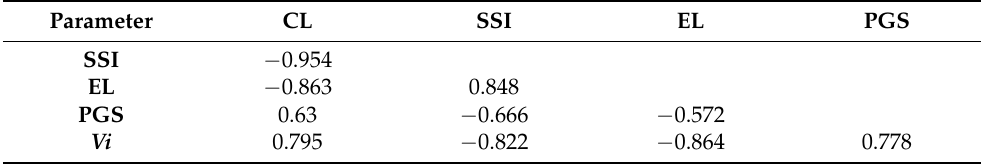
Table 1. Pearson coefficients of linear correlation ( p < 0.05) between CL—coleoptile length, SSI—salt susceptibility index, EL—electrolyte leakage, PGS—percentage of germinated seeds, Vi —vigor of germinating